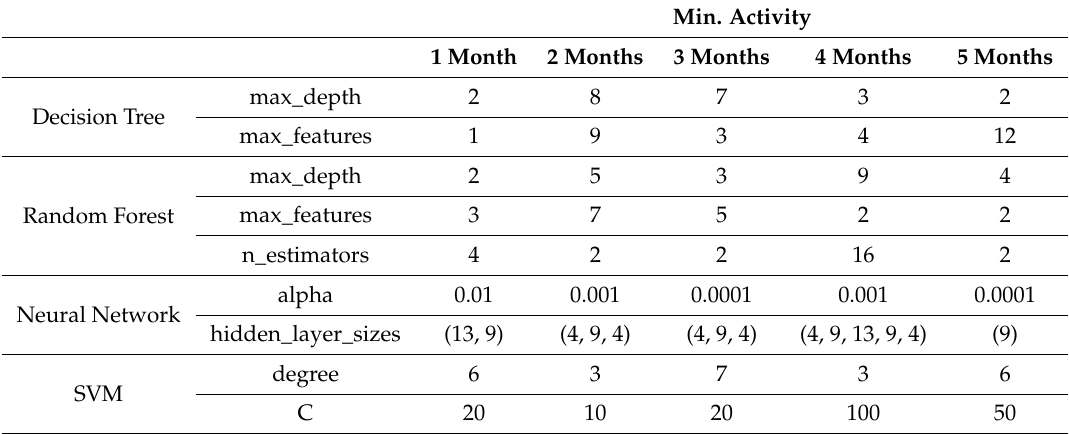
Table A24. The best values of the hyperparameters for the models which uses the full set of features for the Enron dataset with two hierarchy levels.